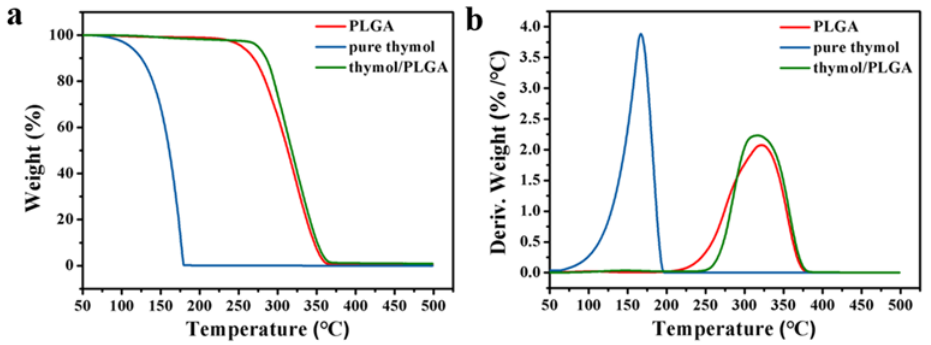
Figure 4. Thermogravimetric ( a ) and derivative thermogravimetric ( b ) of free thymol, PLGA, and thymol-loaded PLGA microparticles.